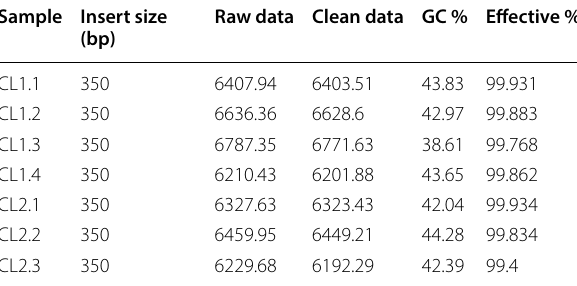
Table 3 The statistical table of data Sample Insert size